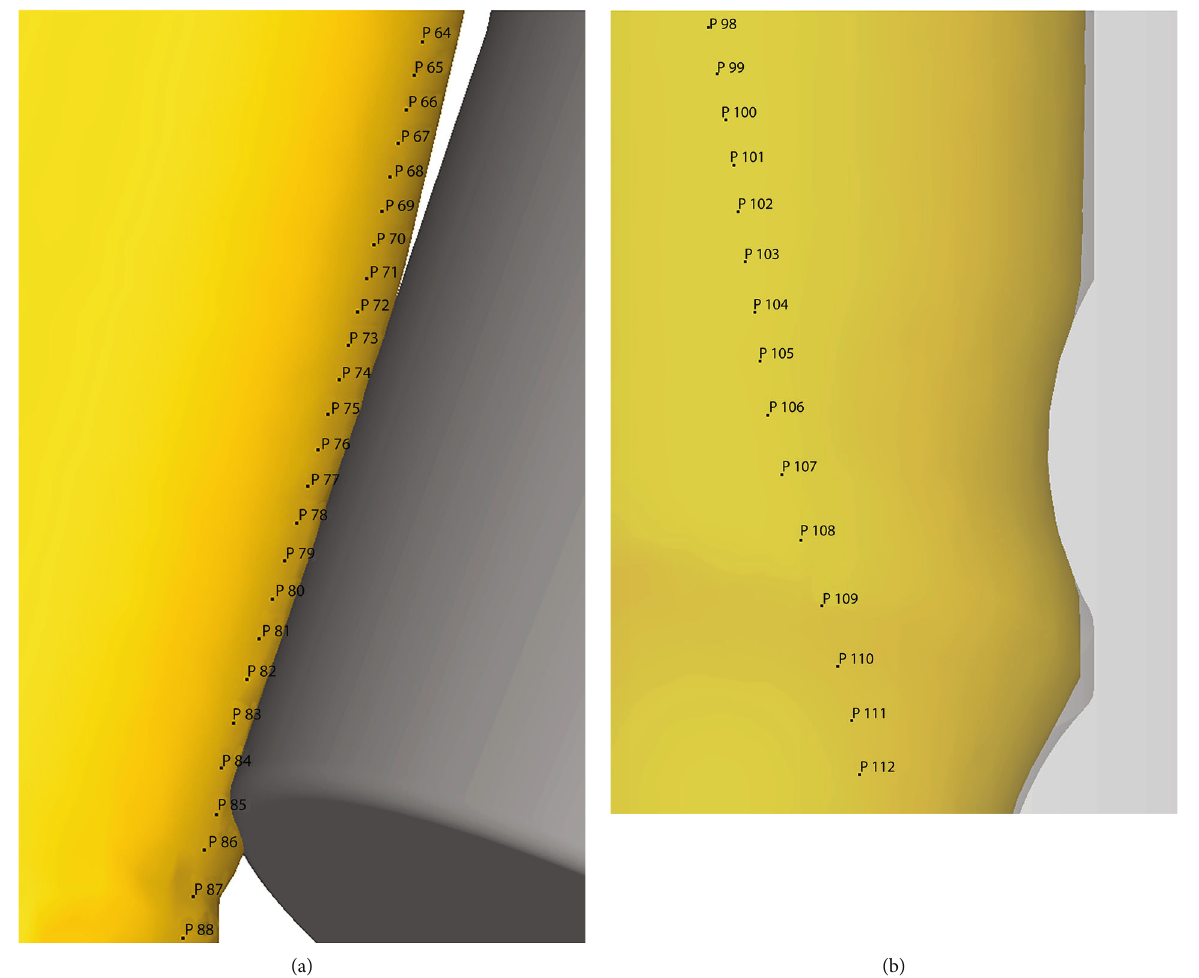
Figure 8: Length of (a) rolling and (b) forming zones.